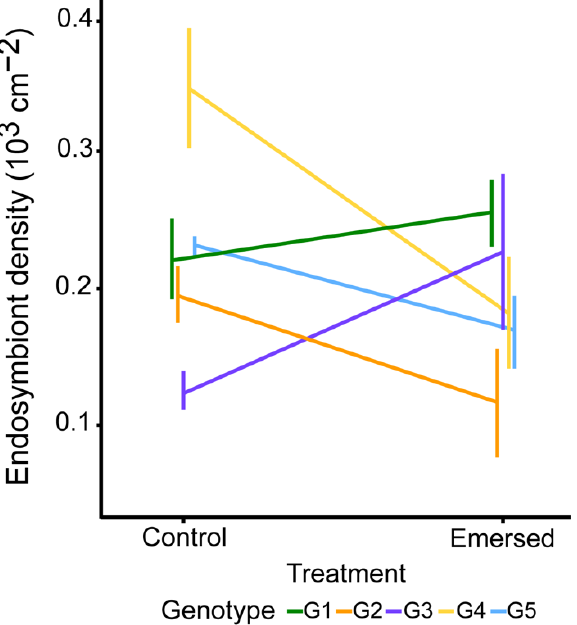
Figure 4. Reaction norms of all genotypes showing changes in algal endosymbiont density level following exposure to increased emersion duration.